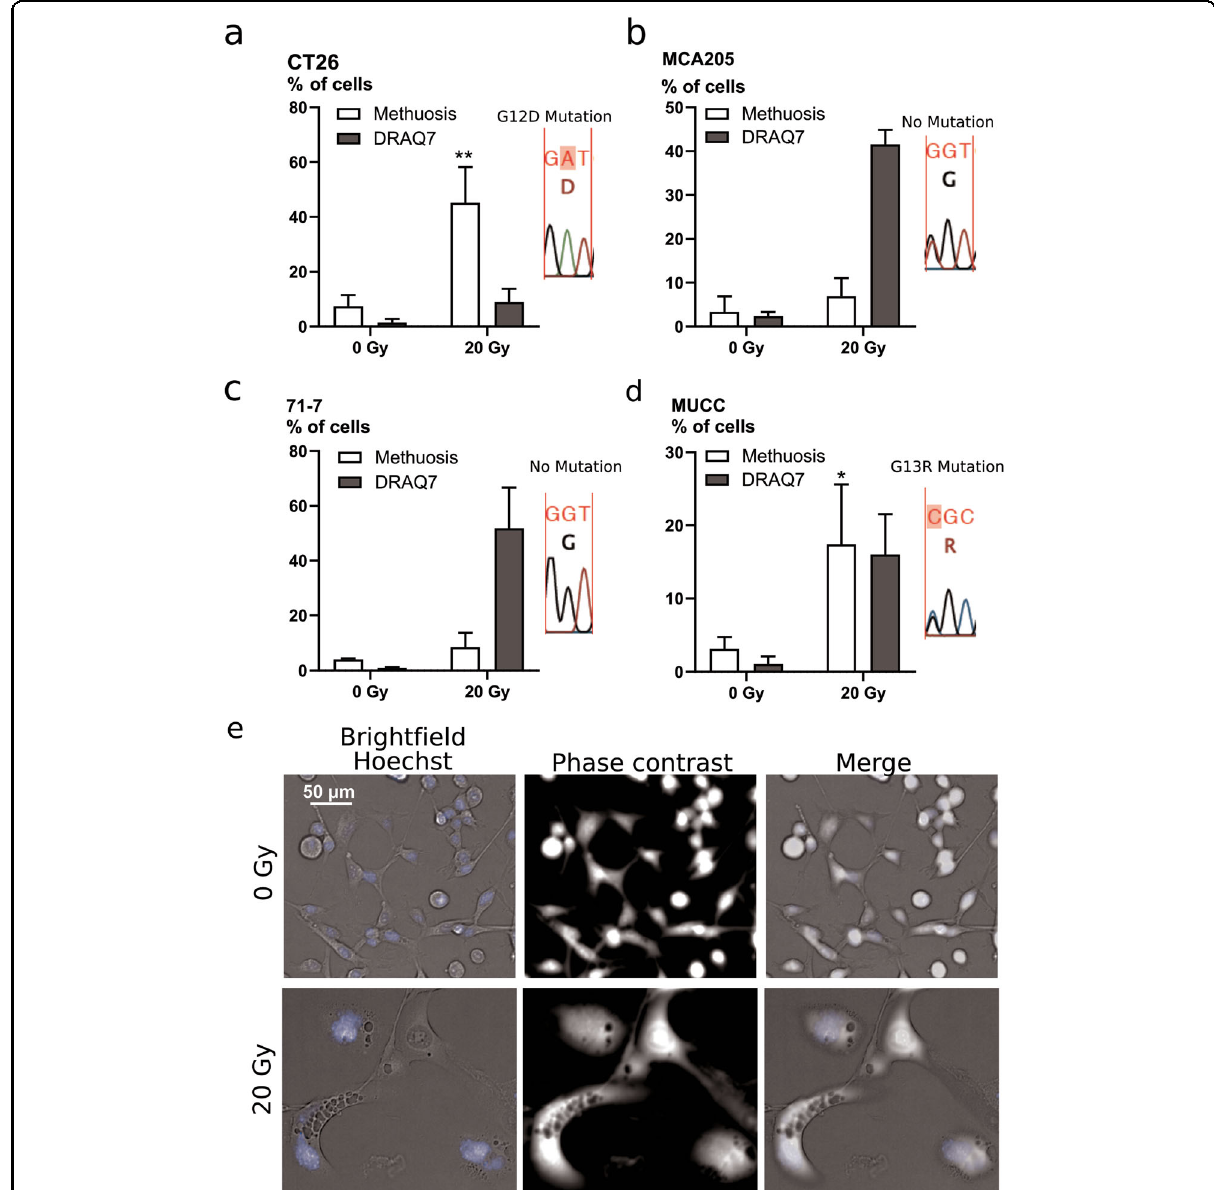
Fig. 7 Ionizing radiation induces features of methuosis. Microscopic evaluation of the presence of phase-lucent vacuoles in CT26 ( a ), MCA205 ( b ), 71-7 ( c ), and MUCC ( d ) cells after 72 h irradiation with 20 Gy. An example of pictures for CT26 cells is shown in e . Means ± SEM are shown ( n = 3). An unpaired t -test was performed for the methuosis data. Asterisks (*) show the comparison to 0 Gy. * p ≤ 0.05, ** p ≤